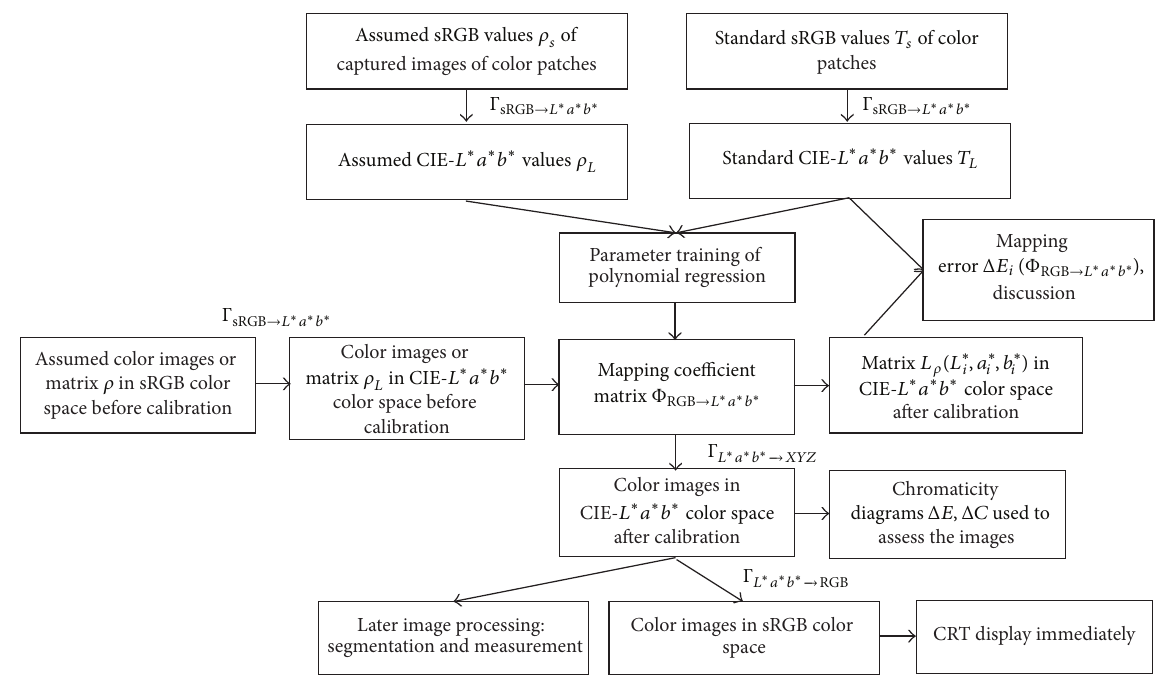
Figure 4: Schematic diagram of the calibration algorithm in CIE- 𝐿 ∗ 𝑎 ∗ 𝑏 ∗ color space.